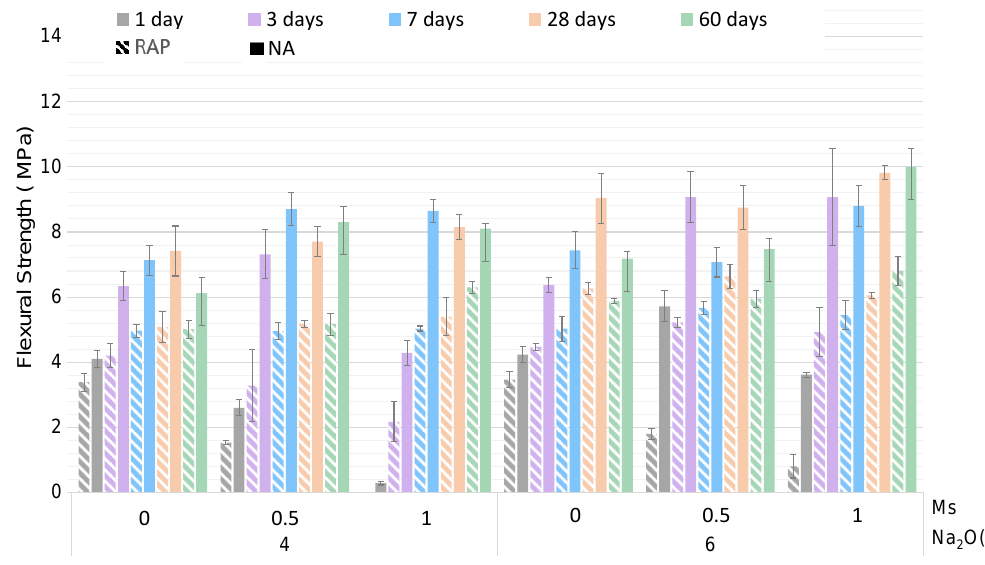
Figure 9. Flexural strength of mortars.